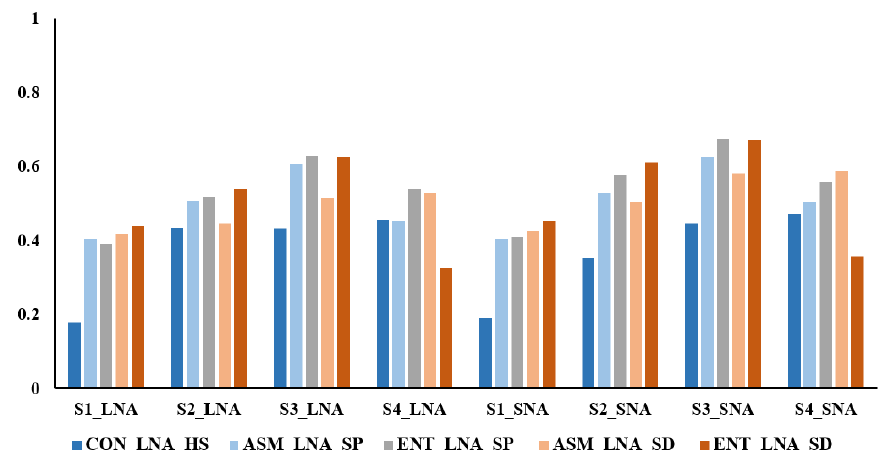
Figure 9. Feature screening results, in which S1, S2, S3, and S4 represent the early jointing, late jointing, booting, and heading stages of wheat, respectively.